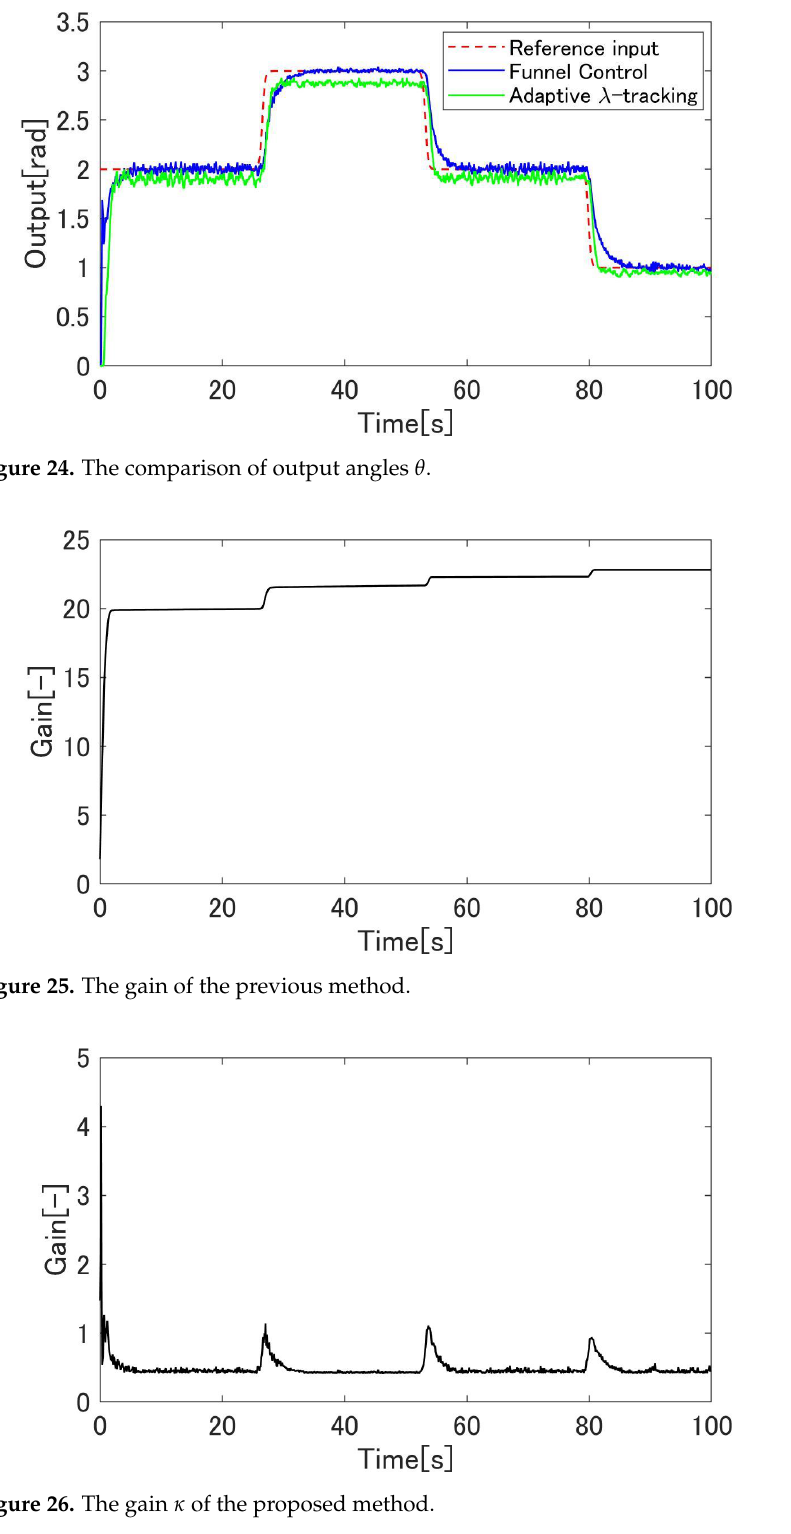
Figure 26. The gain κ of the proposed